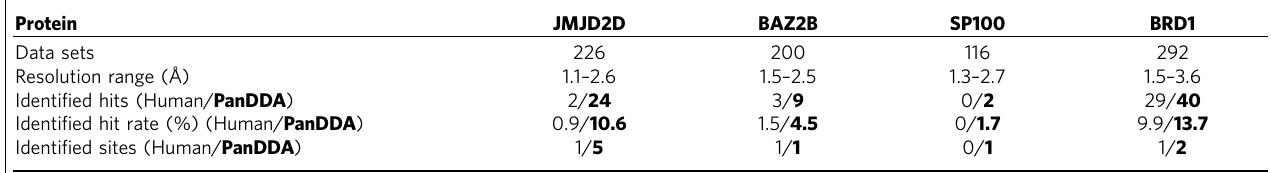
PanDDA, Pan-Data set Density Analysis. Allfragmentscreensconsistedofa single soaked compound perdataset.An identifiedsitecomprisesmorethantwobinding ligands thatarenotheavilyinteractingwithcrystalcontacts.Numberof hits was determined as number of data sets containing a bound ligand. Hit rate was calculated as percentage of data sets containing bound